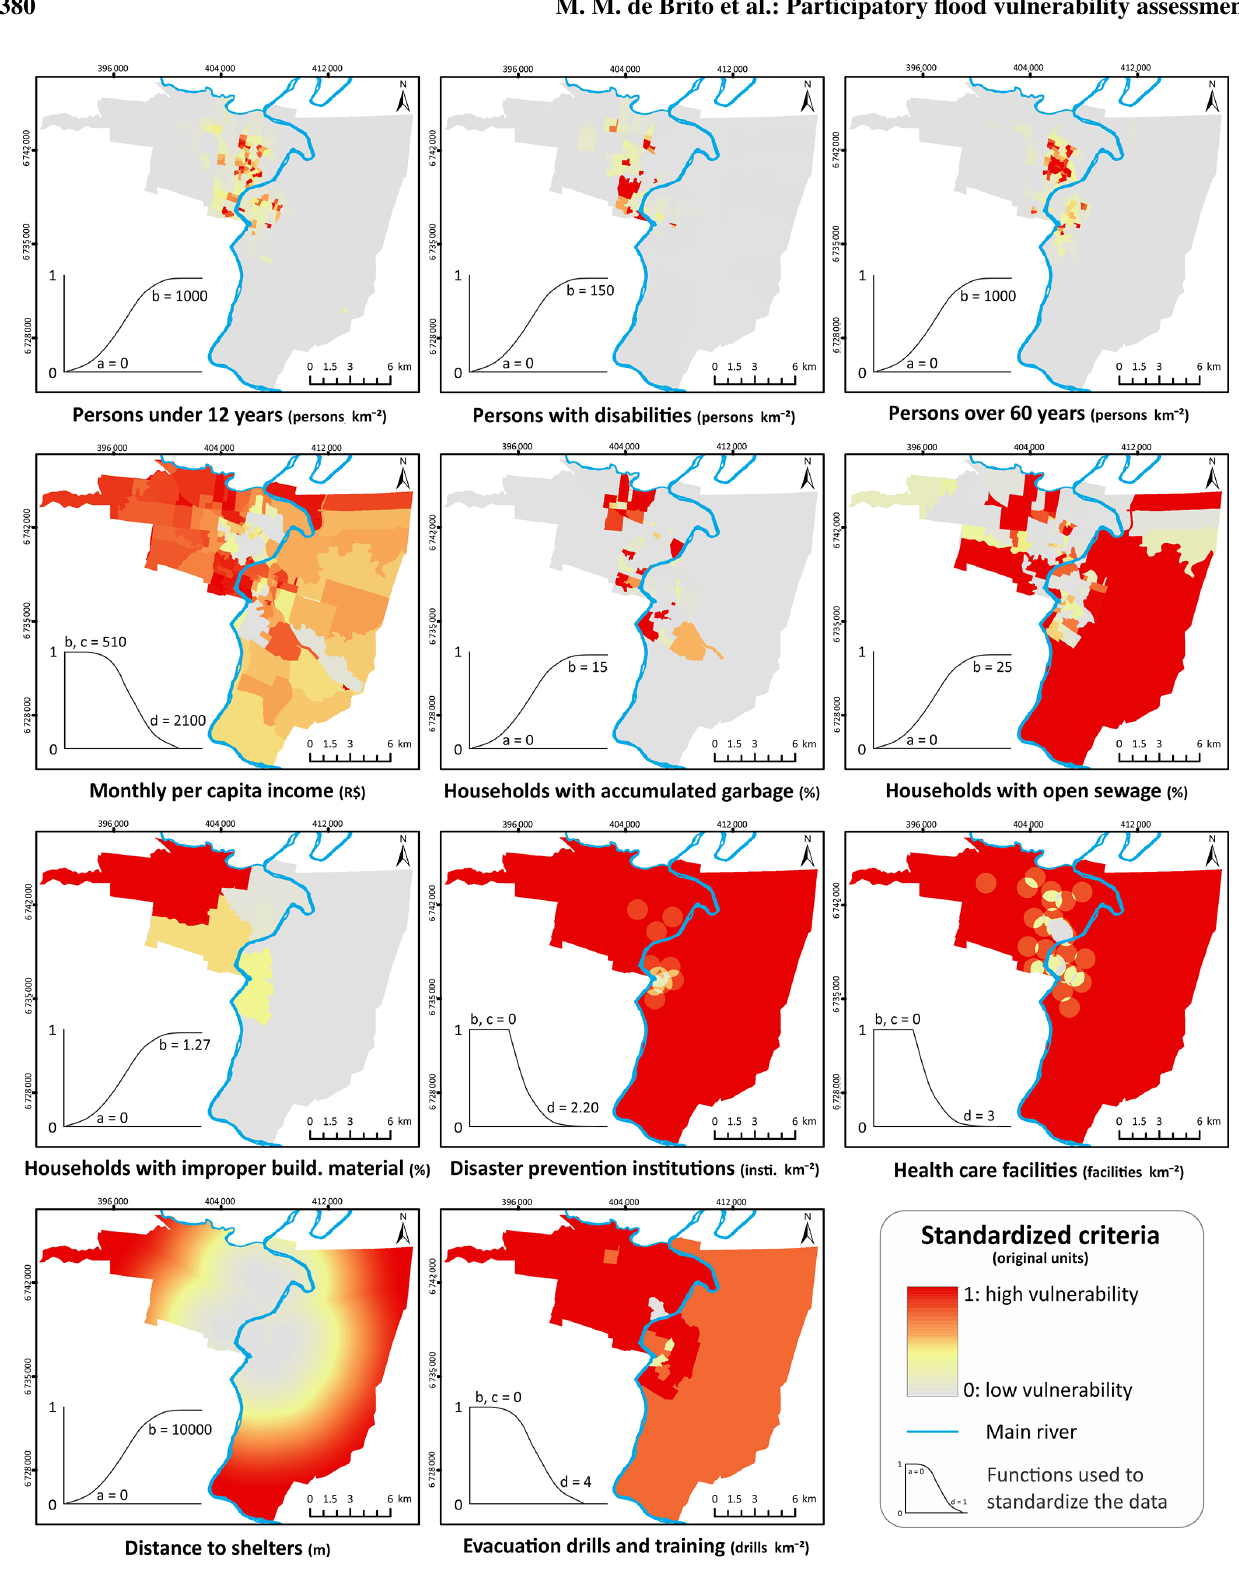
Figure 4. Standardized criteria maps, utility functions, and control points that govern their shape ( a , membership rises above 0; b , member- ship becomes 1; c , membership becomes 0). The original units used to represent the criteria are shown in